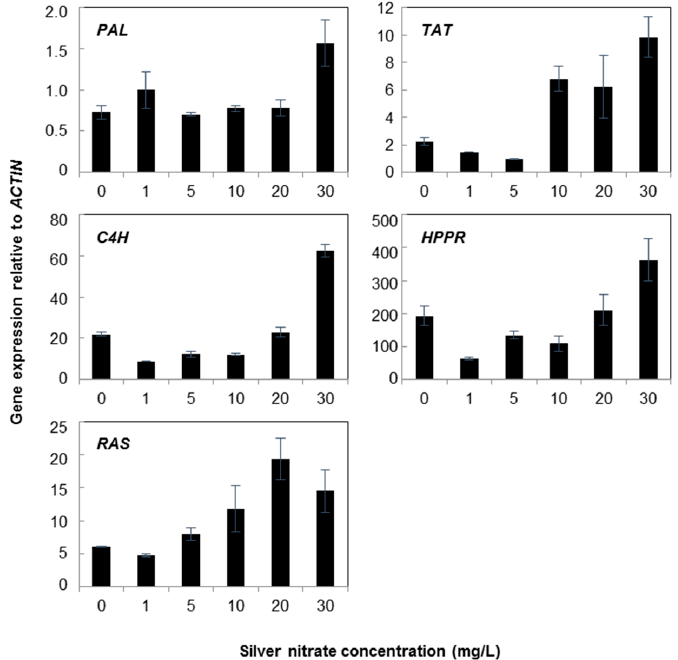
Figure 3. Expression of rosmarinic acid biosynthetic genes in Agastache rugosa calli treated with various concentrations of silver nitrate for 72 h. Transcription levels for each gene were analyzed relative to that of ACTIN . Error bars show standard deviation values.